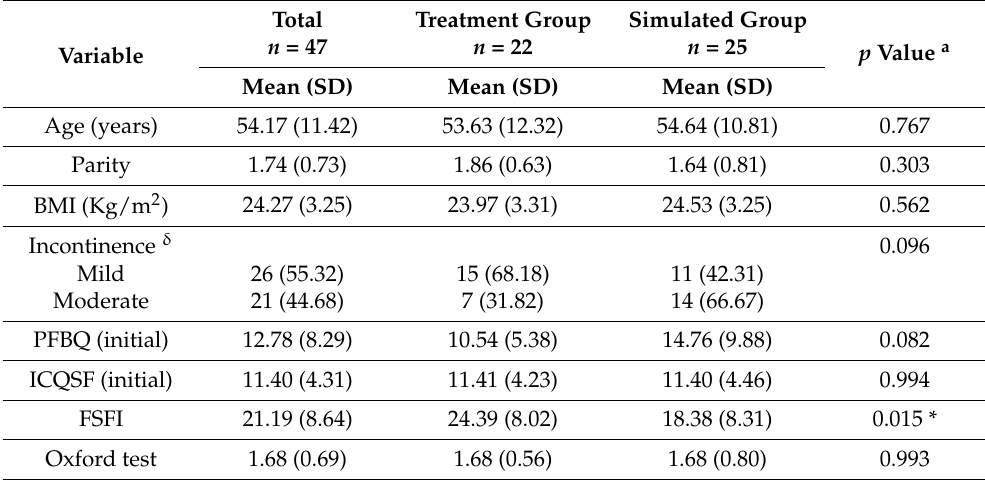
Table 1. General characteristics of the patients according to the assigned treatment.